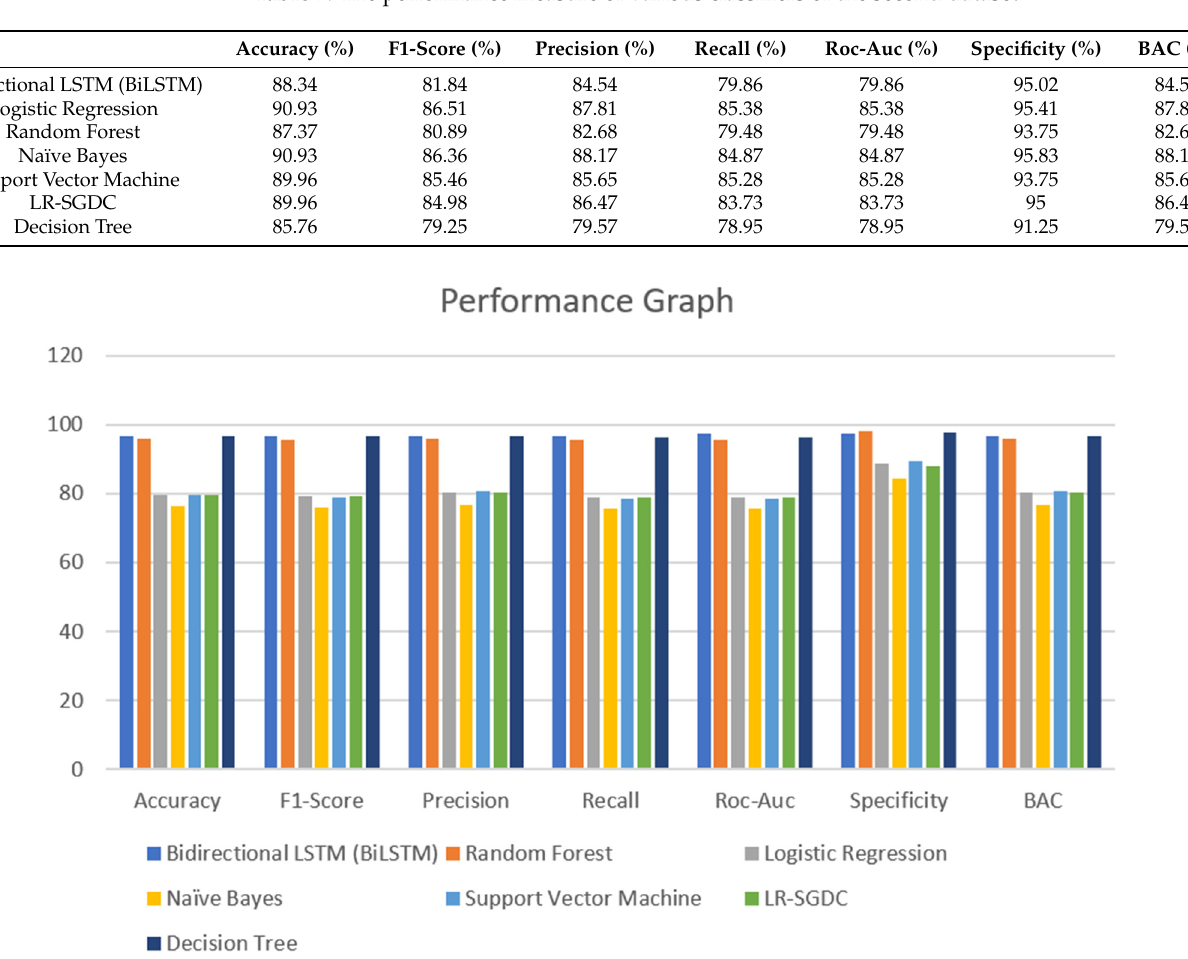
Figure 14 . Performance graph of different classifiers for the second dataset.